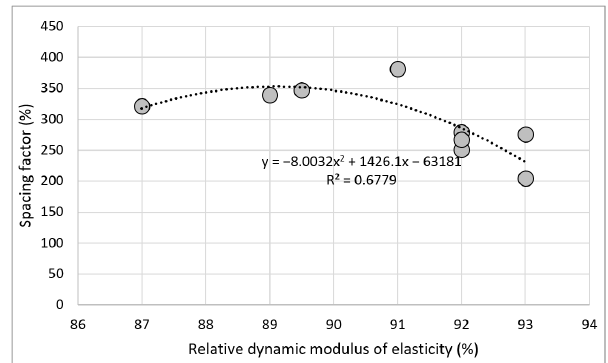
Figure 16. Spacing factor and specific surface area of concrete. Figure 17. Spacing factor and relative dynamic modulus of elasticity of concrete.